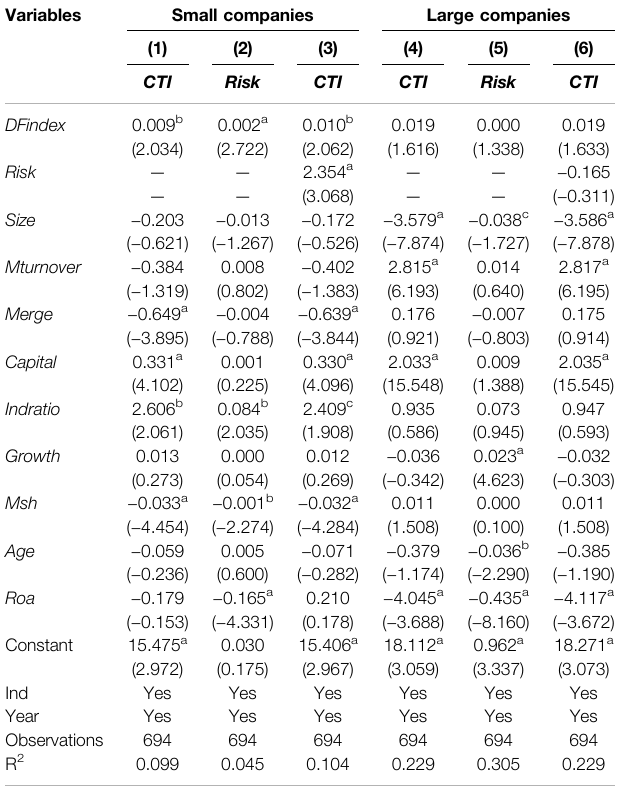
TABLE 7 | Estimations of the moderating effect of company scale.